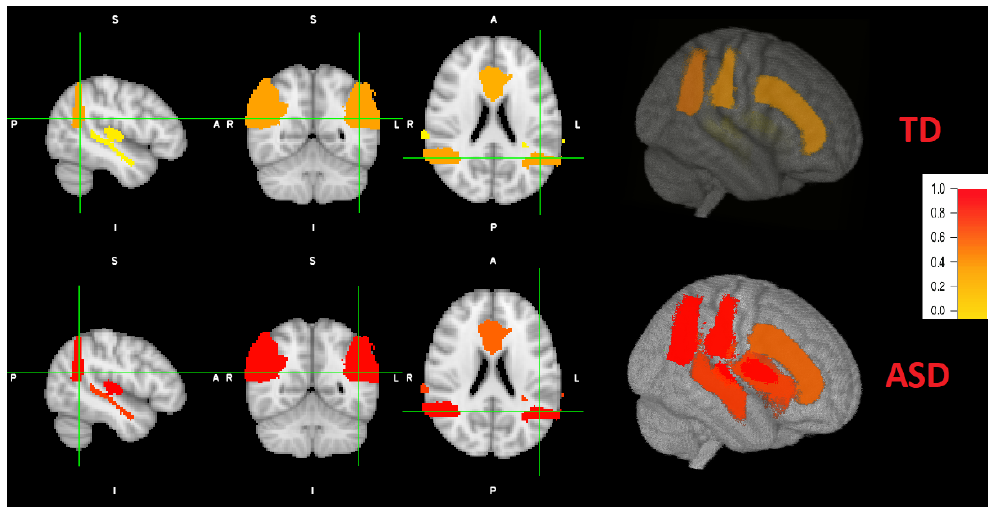
Figure 8. Coronal, sagital and axial 2D views and a 3D view of both ASD and TD example. Brain areas for the ASD individual are more severely distributed (red highlights) than TD peer (more yellow highlight